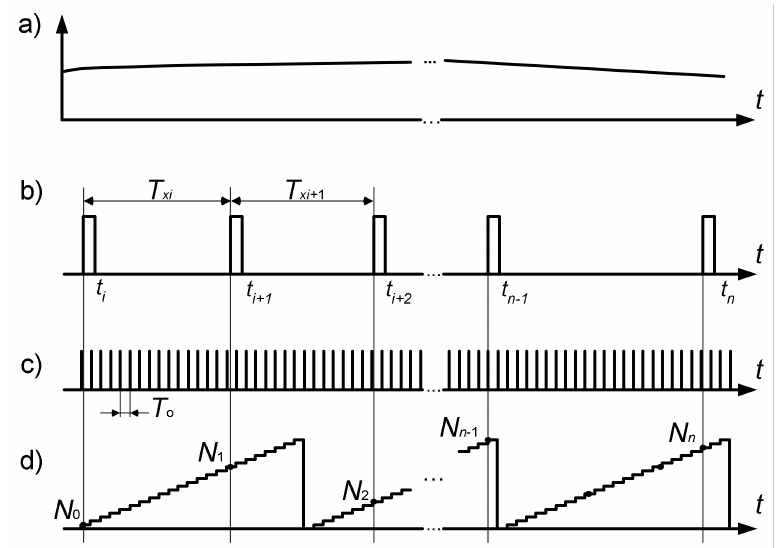
Figure 2. The principle of continuous measurement of the periods of signal of a variable frequency with a single counter. The individual positions are shown: ( a ) exemplary waveform x ( t ), ( b ) variable frequency waveform produced by the X/f converter, ( c ) clock signal waveform with frequency f 0 , ( d ) counter reading of the f/N converter at the beginning and end of each period T xi